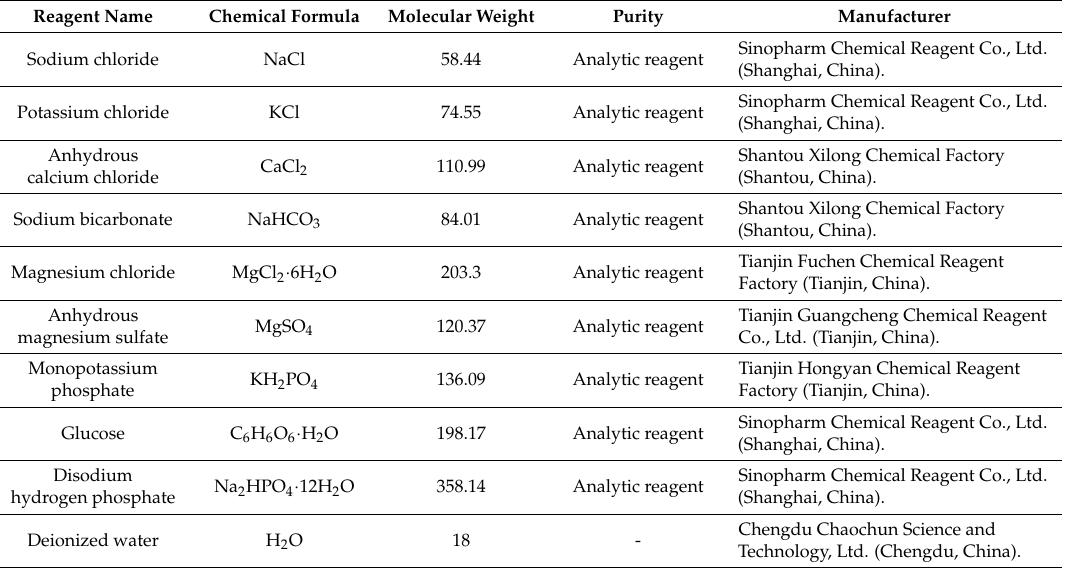
Table 3. Analytic reagents used in the experiment.